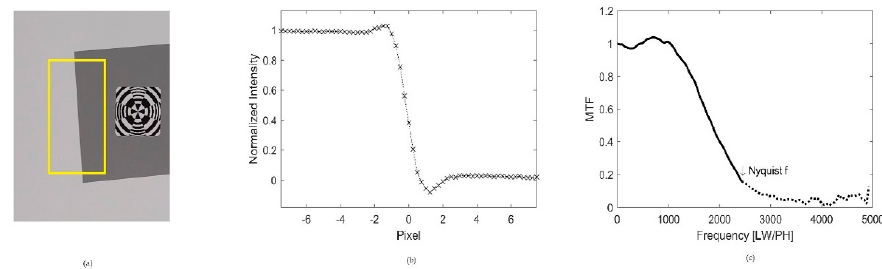
Figure 4. Illustration of slanted edge-based modulation transfer function (MTF) estimation process: ( a ) selection of a region of interest (ROI), ( b ) normalised edge spread function (ESF) and ( c ) estimated MTF.